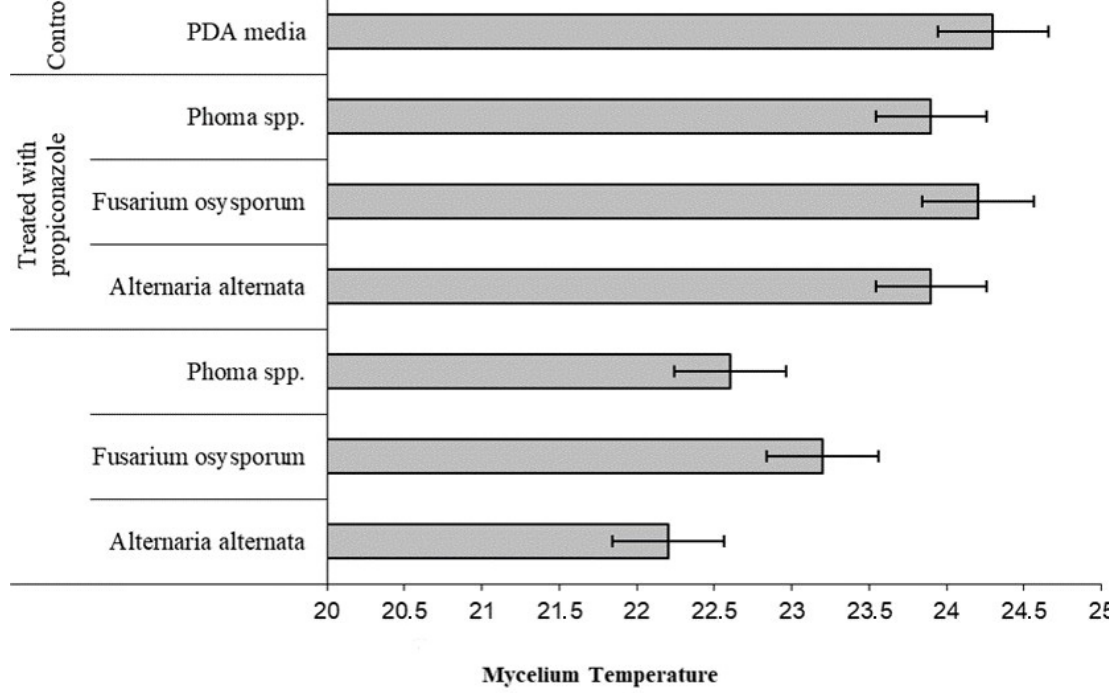
Figure 3. Average temperature of control plates and different fungi mycelium grown on PDA media with and without Propiconazole fungicide. Horizontal bars indicate SD.